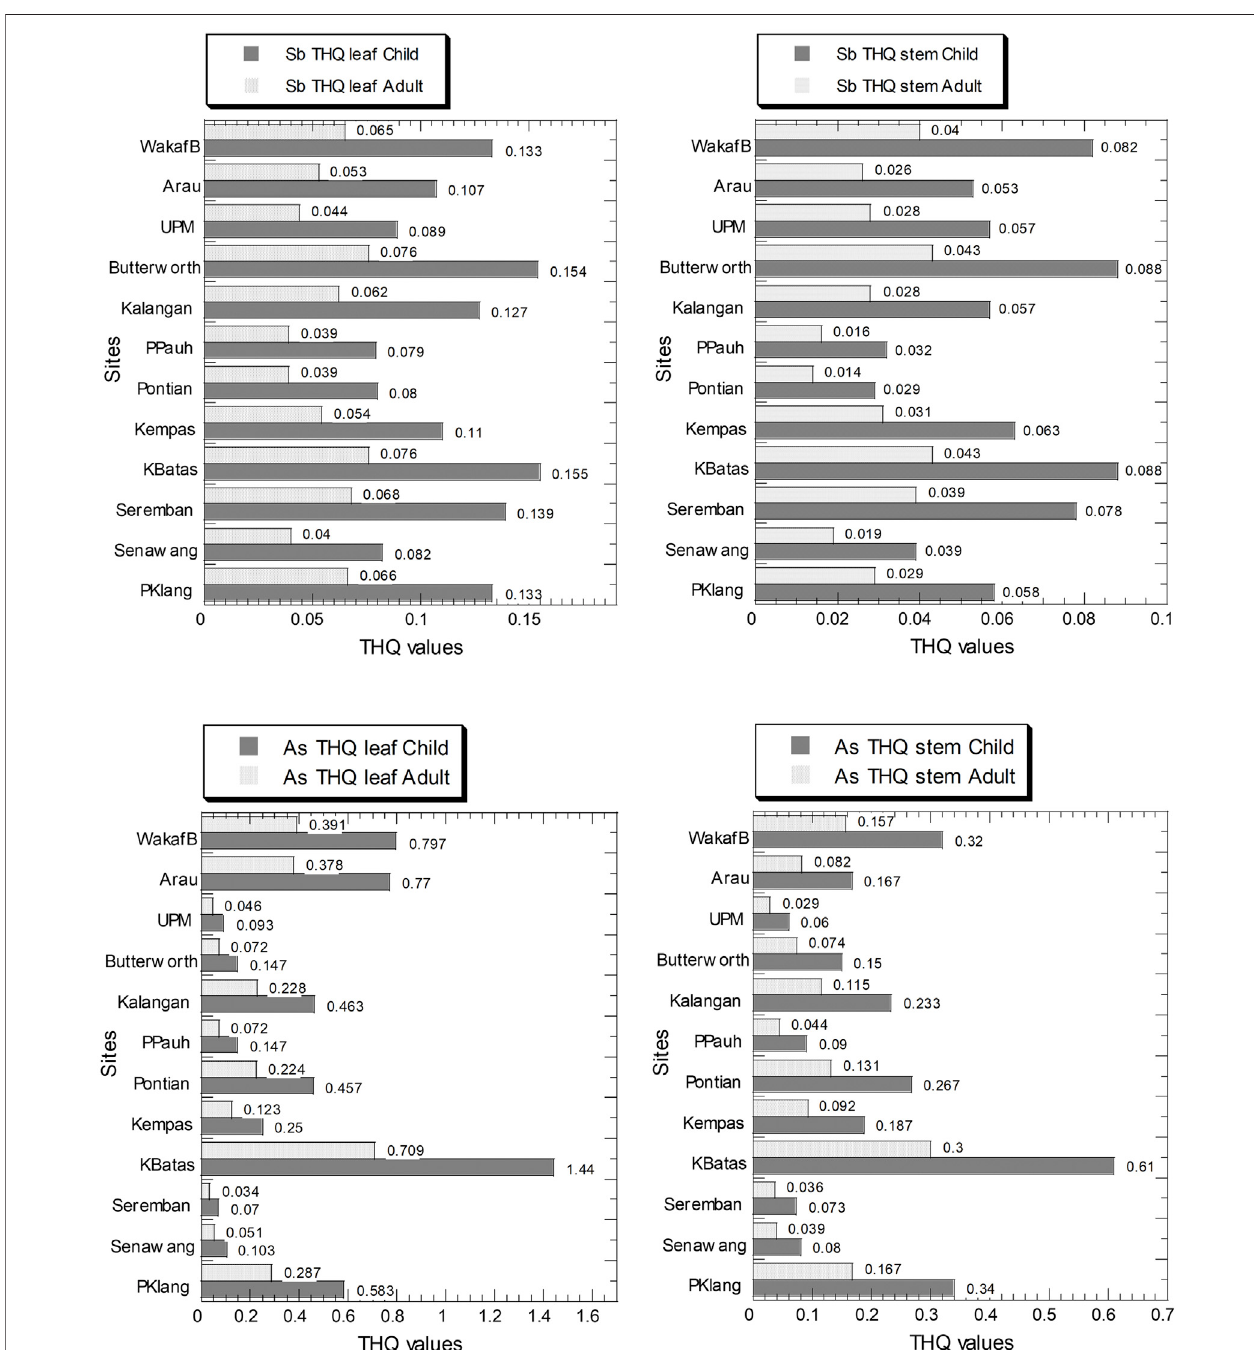
FIGURE 4 | Target hazard quotient (THQ) values (unitless) of As and Sb in the leaves and stems of Centella asiatica collected from 12 sampling sites (numbers in white circles (1 – 12) in Figure 1 ; S1 – S12 in Supplementary Table S1 ) in Peninsular Malaysia. The X -axes are based on a linear scale.